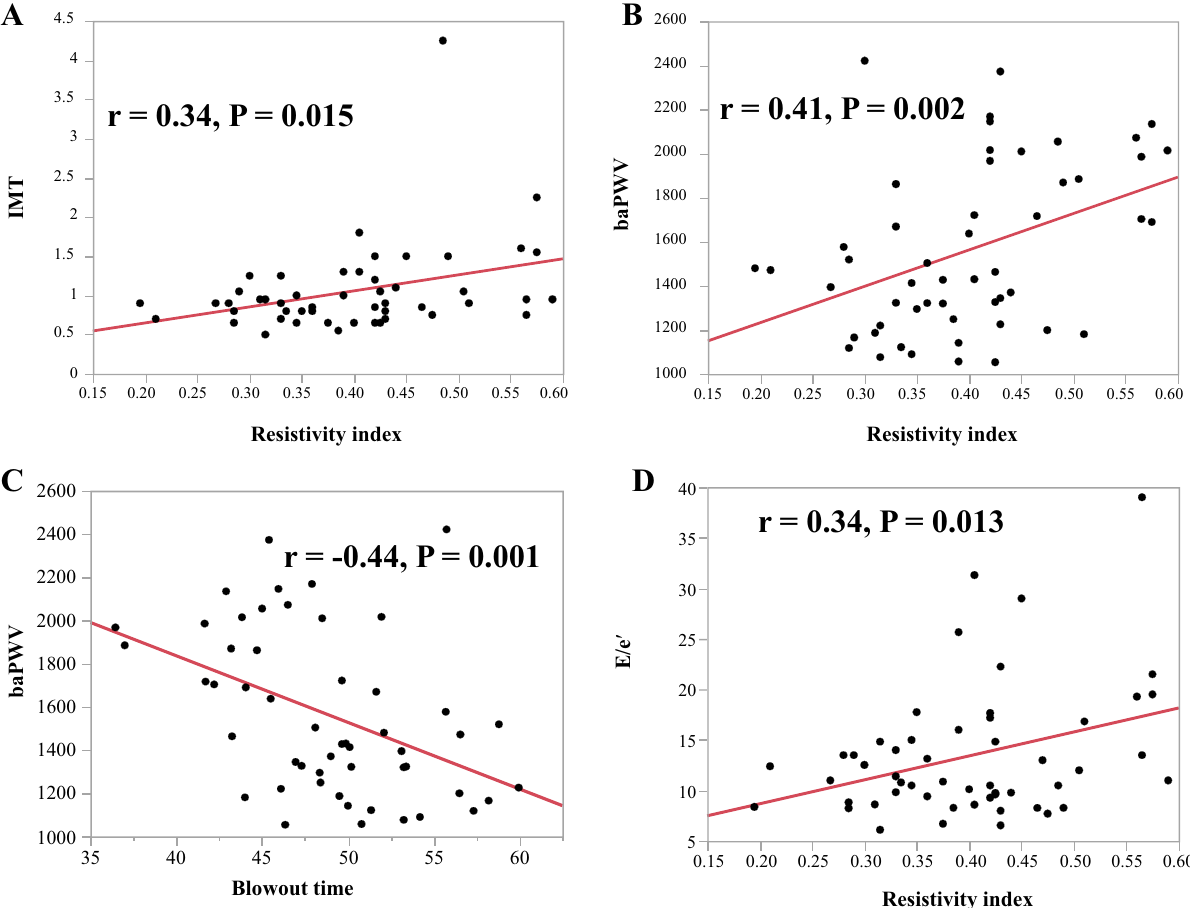
Figure 2. Correlations between resistivity index and intima-media thickness (IMT) ( A ), Brachia-ankle pulse- wave velocity (baPWV) ( B ), and early diastolic velocity to early diastolic myocardial velocity (E/e’) ratio ( D ). Also shown are the correlations between blowout time and baPWV ( C ). The mean RI was positively correlated with the mean IMT (r = 0.34, P = 0.015; A ), baPWV (r = 0.41, P = 0.002; B ) and the E/e’ ratio (r = 0.34, P = 0.013; D ). The mean BOT was negatively correlated with the mean baPWV (r = −0.44, P = 0.001; C